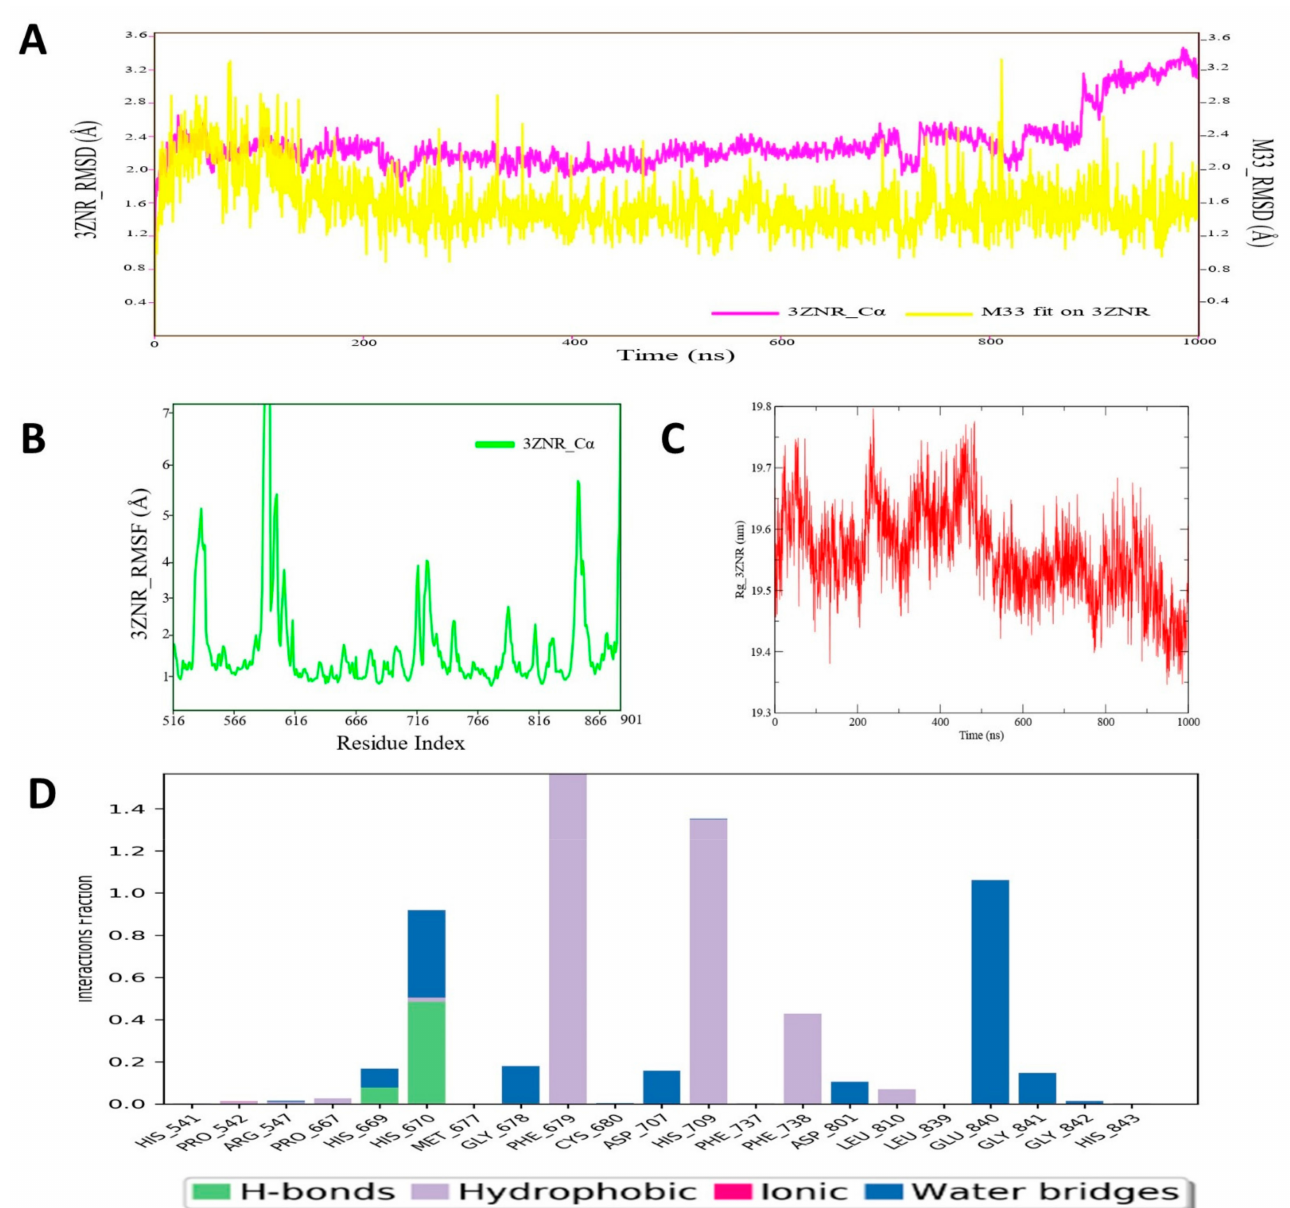
Figure 13. ( A ) RMSD profile of HDAC7 (3ZNR) protein backbone and compound M74 during 1000 ns simulation; ( B ) RMSF profile of c-KIT (6XVB) protein backbone during 1000 ns simulation; ( C ) RoG profile of c-KIT (6XVB) protein backbone during 1000 ns simulation; ( D ) illustration of the c-KIT (6XVB)–M74 contacts or interactions map monitored during 1000 ns simulation